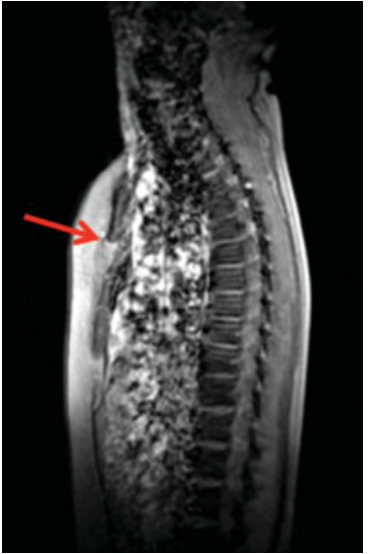
Fig. 2 T2-weighted sagittal MRI showing the fracture (indicated by arrow) of the sternum. MRI, magnetic resonance imaging.